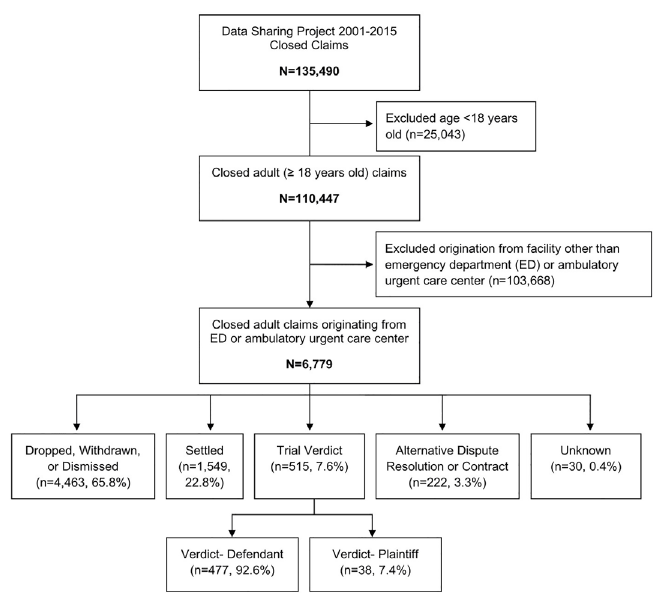
Figure 1. Claim resolution of closed claims in adult emergency departments or urgent care